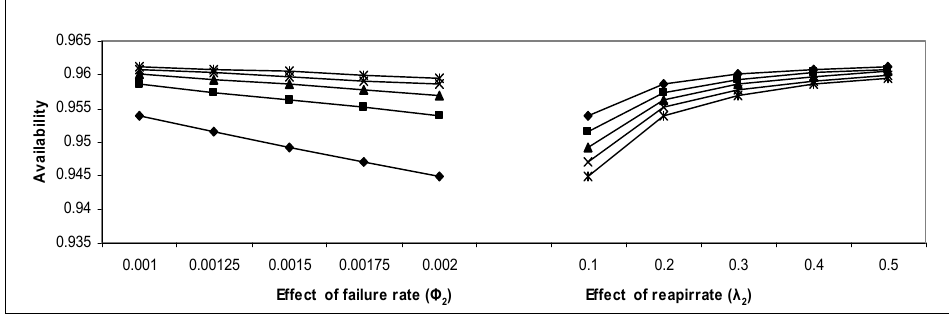
Figure 3. “Effect of failure & repair rate of ESP subsystem on subsystem availability”.